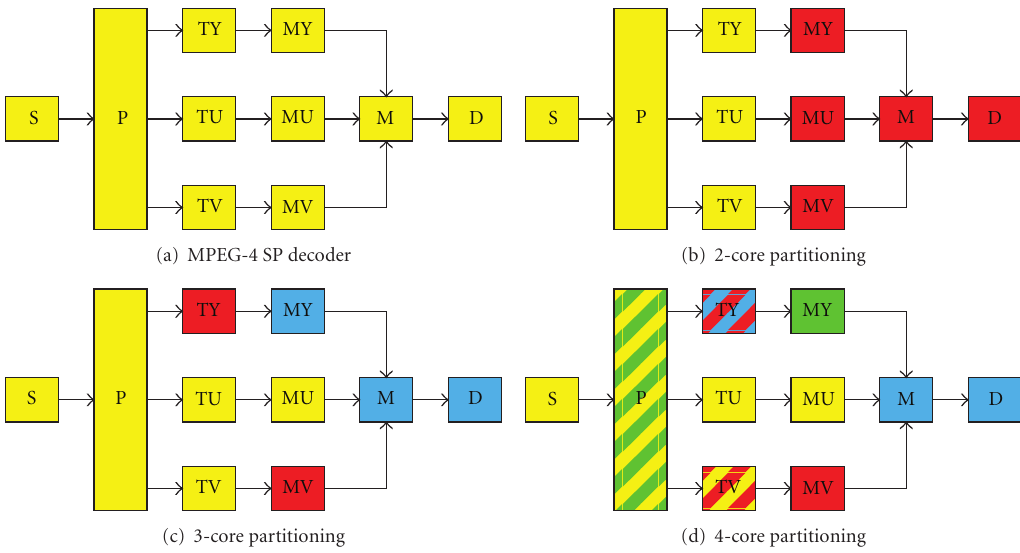
Figure 9: Partitions of the parallel version of the MPEG-4 SP decoder for the 1, 2, 3, and 4 cores configurations.